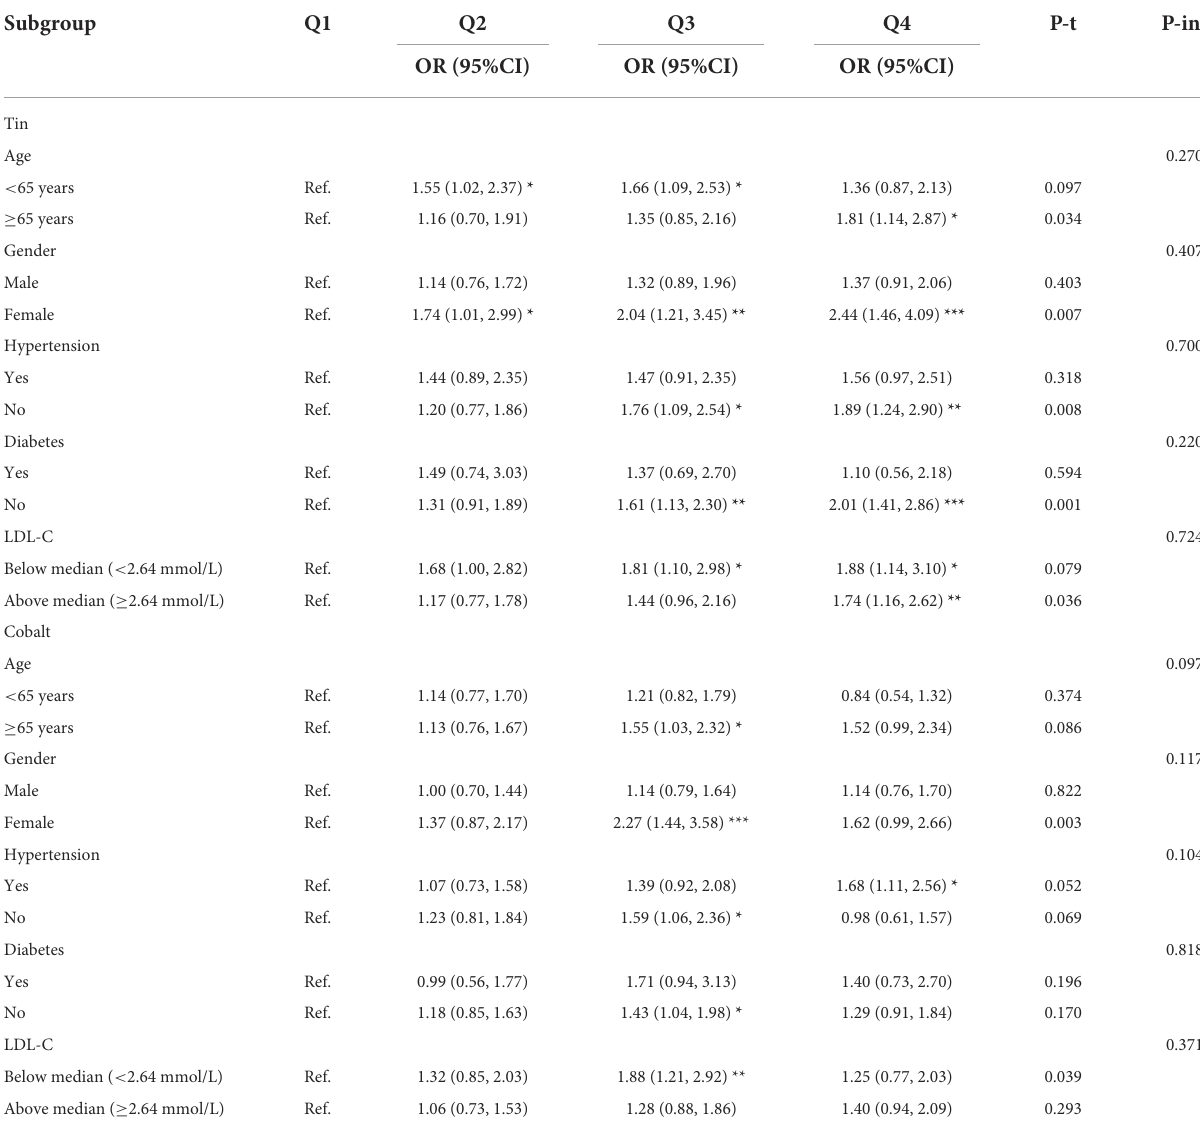
TABLE 3 Subgroup analysis of the association between urine trace metals and hearing loss. Subgroup